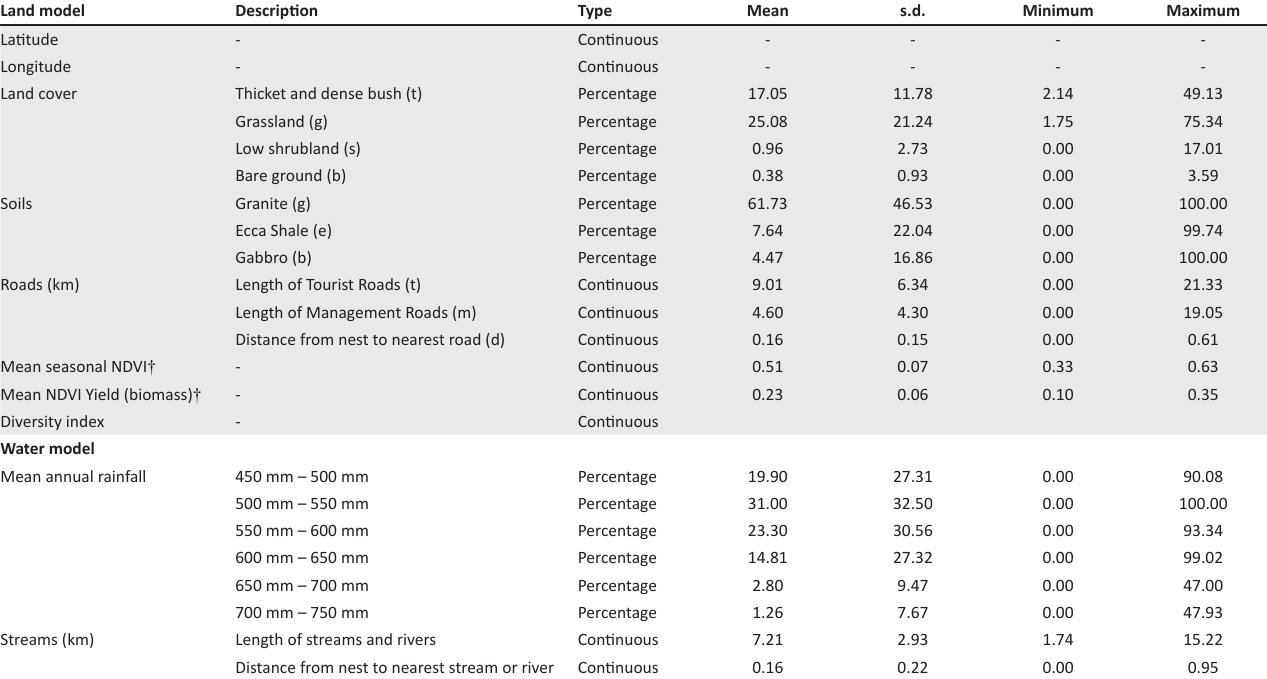
TABLE 1: Fixed effects included in the Southern Ground-hornbill nesting success LAND and WATER generalised linear mixed models. Land